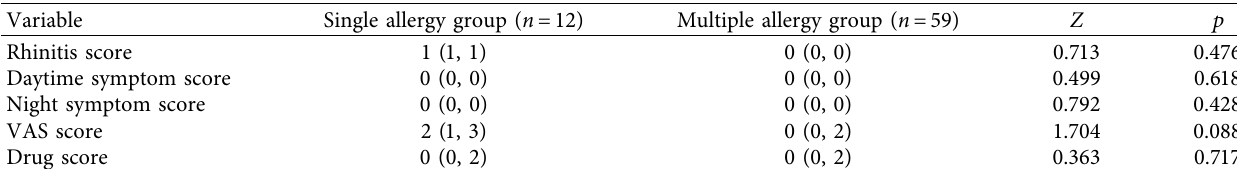
Table 8: Comparison of scores between the single allergy group and multiple allergy group.